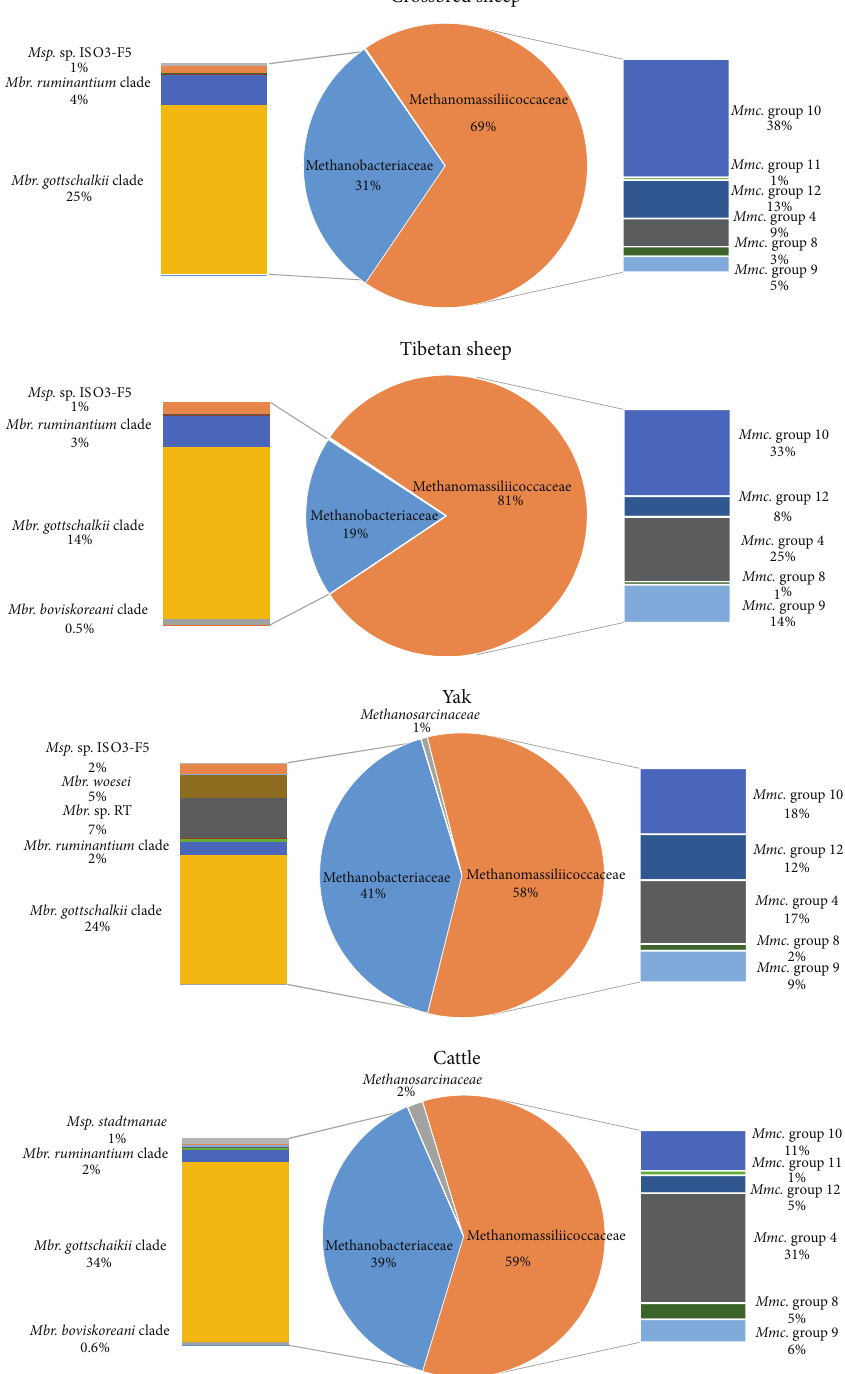
Figure 1: Archaeal taxonomic composition at the family level (pie chart) and species level (bar chart) for crossbred sheep, Tibetan sheep, yak, and